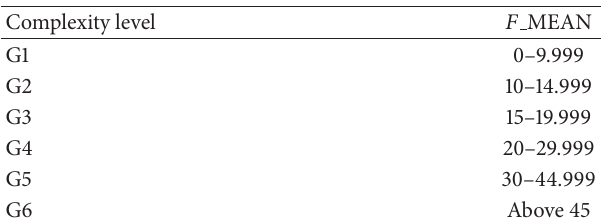
Table 4: 𝐹 MEAN values for 50 test images. Table 5: Classification